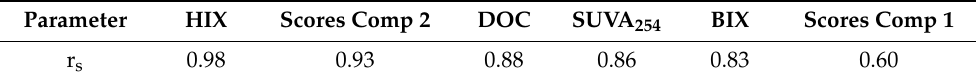
Table 1. Spearman’s rank correlation coe ffi cients of the calculated ranks of the median of the observed parameter (humification index (HIX), dissolved organic carbon (DOC), specific UV absorption (SUVA) and biology index (BIX)) between 2 µ m and 0.2 µ m filtered water samples. It is sorted by good match (high r s